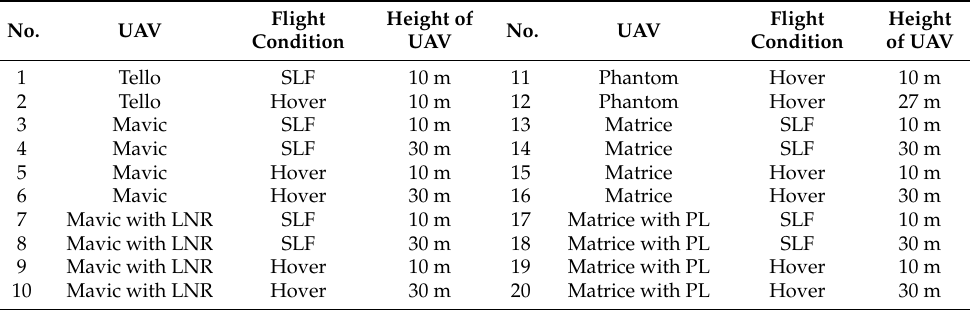
Figure 2. ( a ) The Matrice quadcopter UAV hovering above the two microphones; ( b ) the ½ ″ microphone and Eigenmike with wind socks mounted on tripods. Table 1. Test details. Key: SLF = straight-and-level flight; LNR = low-noise rotors; PL = tested with a 0.461 kg payload.